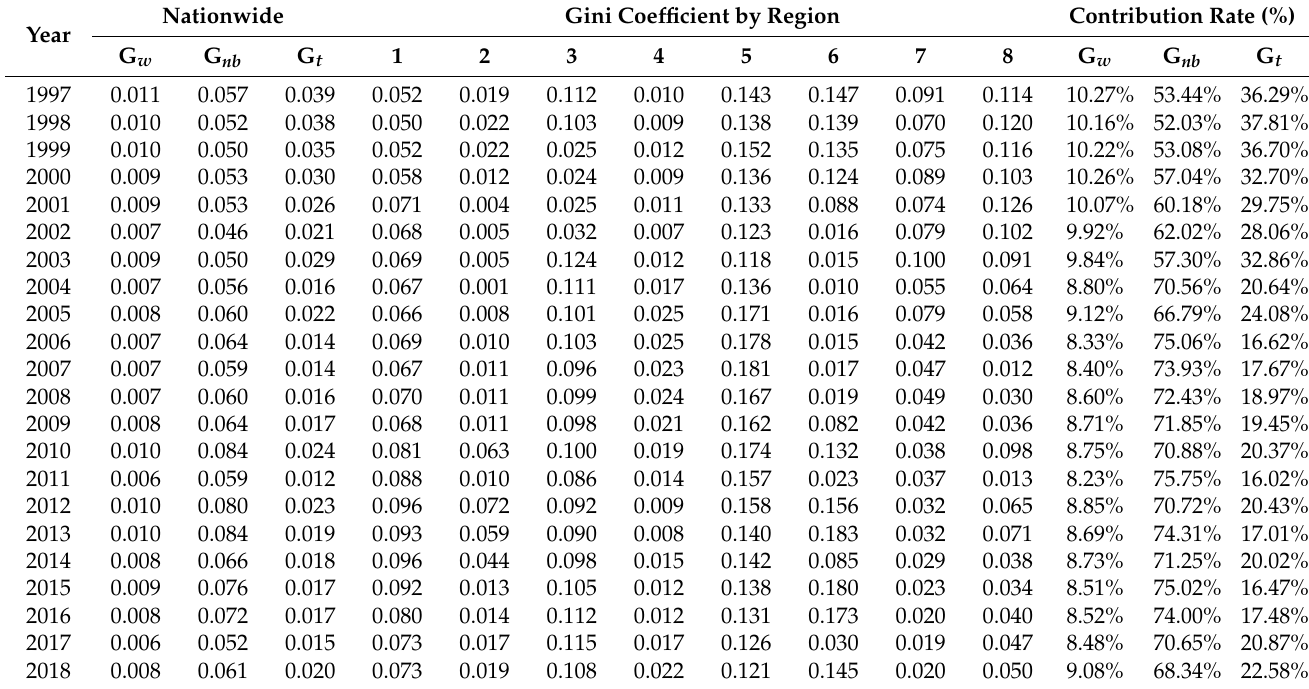
Table 7. Gini coefficients and contribution rates of the eight